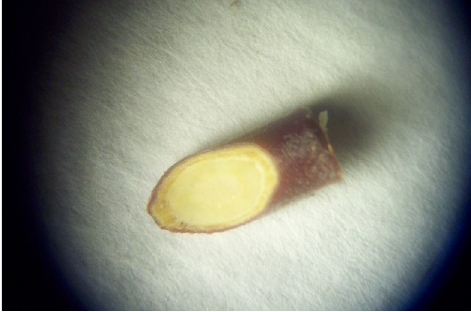
Fig. 1. Low tissue damage seen as a slight darkening in annual branch of ‘Sandra’ at –40 °C (damage points: bark - 1.3, cambium - 1.0, wood - 1.0)